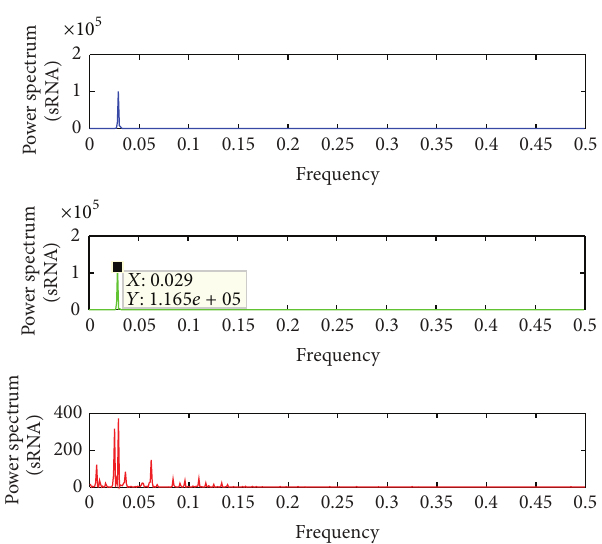
Figure 5: The power spectrum of small RNA presented in Figure